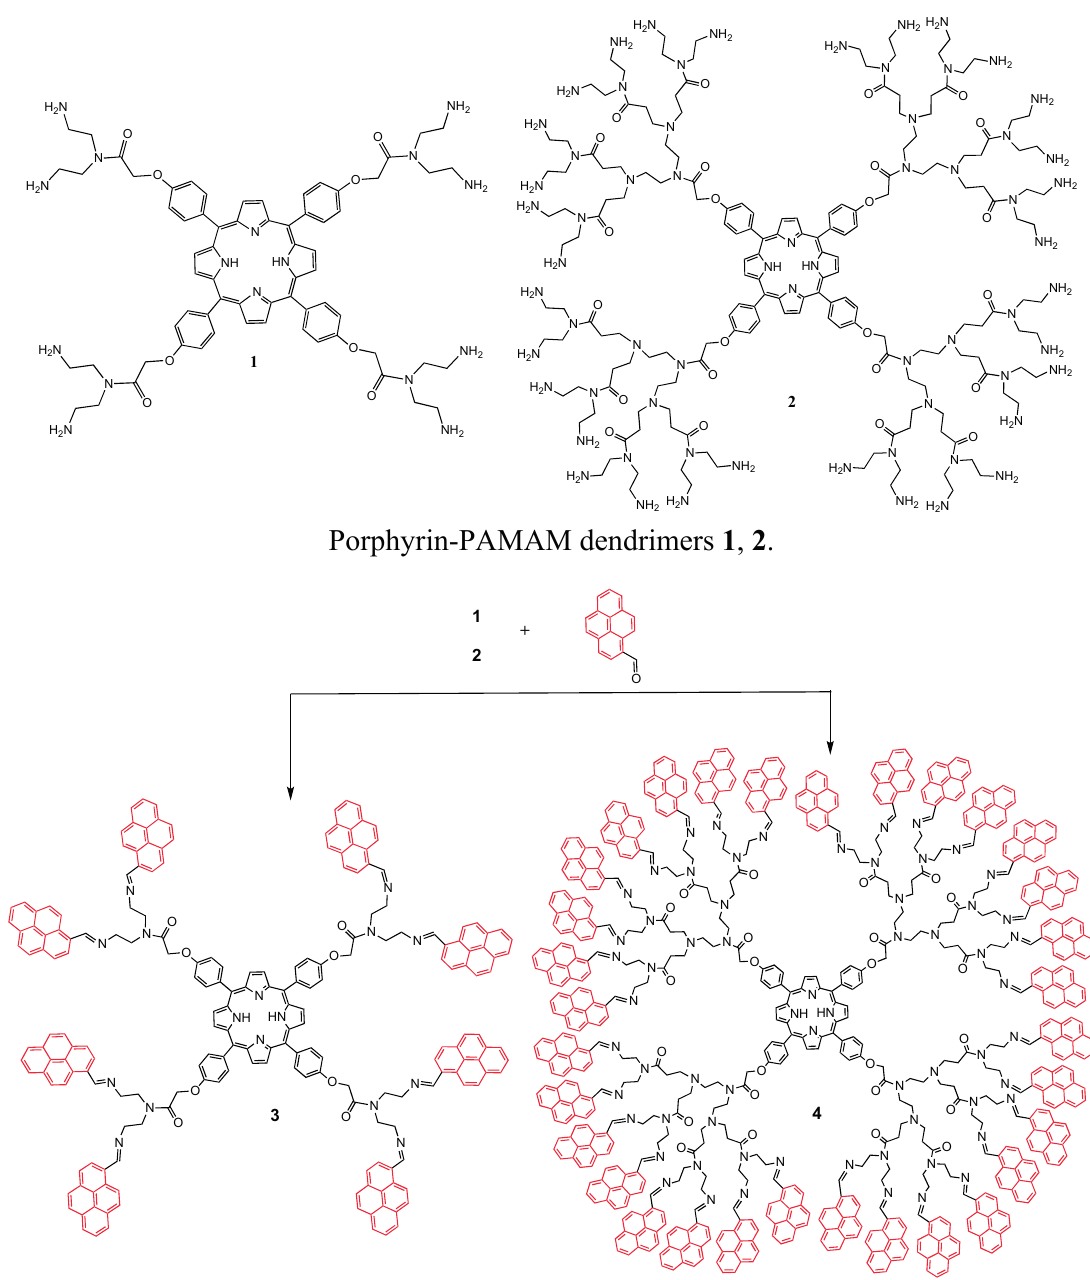
Scheme 1. Chemical structures of the